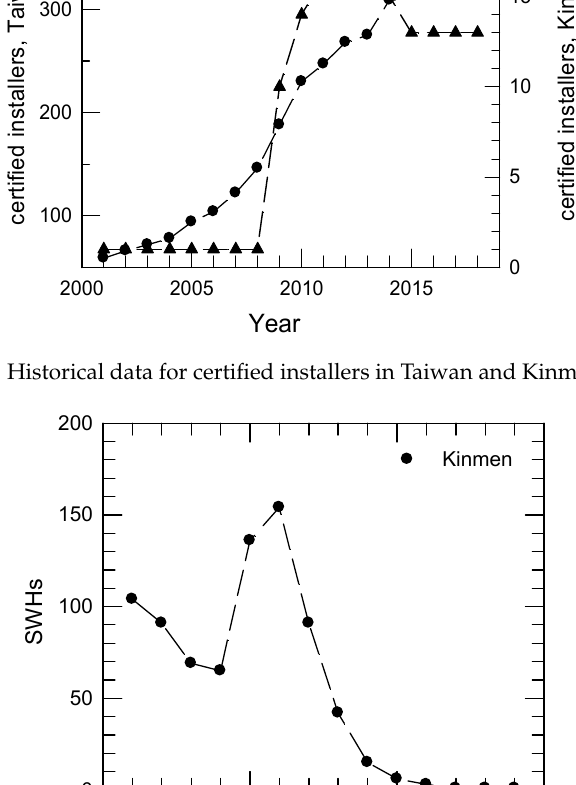
Figure 11. System replacement in Kinmen County.